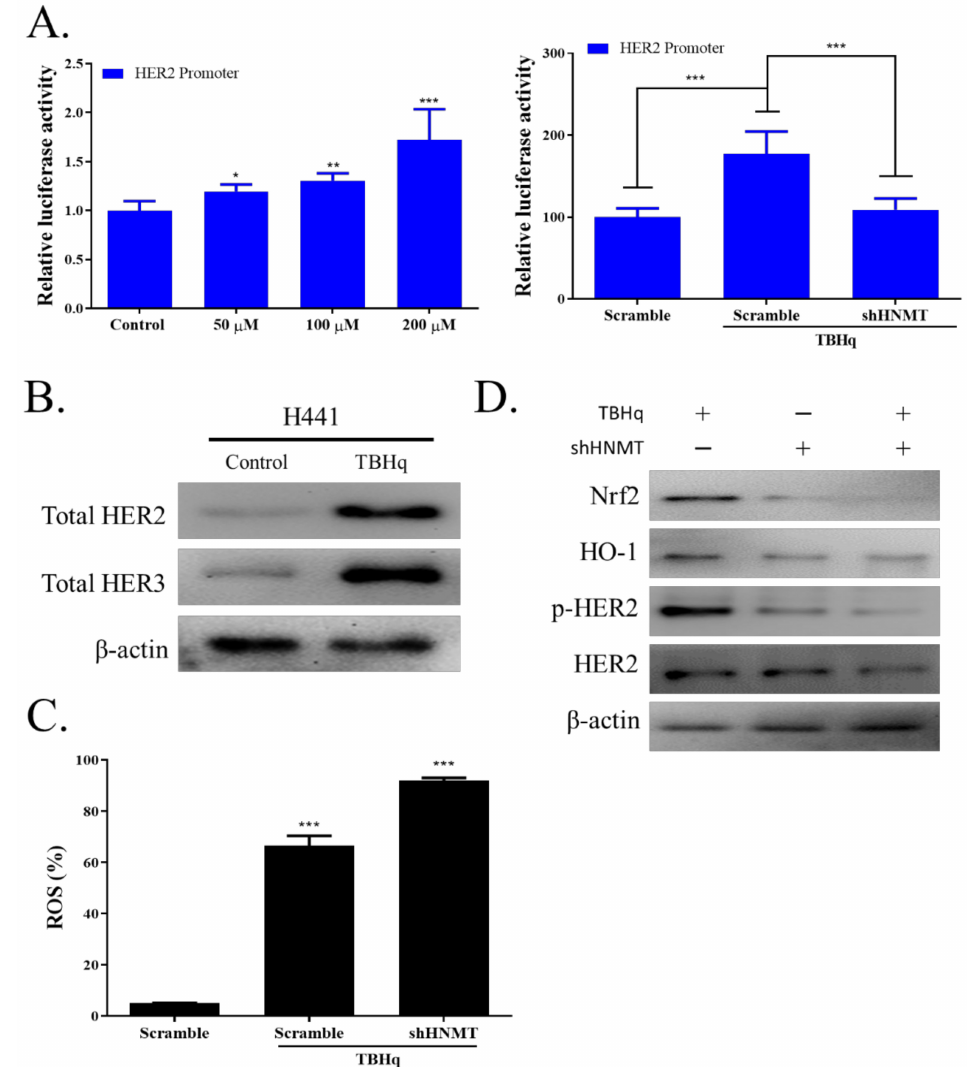
Figure 5. The negative influence of HNMT knockdown on HER2-dependent antioxidant response mechanism in lung cancer cells. ( A ) tBHQ-induced HER2 promoter transcriptional activity induction in a concentration-dependent manner. The H441 cell line was transfected and then treated for 4 h with various concentrations of tBHQ, as indicated. ( B ) Following tBHq treatment, immunoblot analysis showed total protein induction of both HER2 and HER3. Cells were treated with 200 µ M tBHQ for 4 h, lysed to extract the protein, and analyzed through Western blotting. ( C ) Flow cytometric analysis of tBHQ-induced ROS formation in H441 cells with or without shHNMT transfection using the ROS-sensitive fluorometric probe DCFDA. Relative ROS production in all the tested cells was normalized to the TBH1 + shHNMT group. ( D ) Immunoblot analysis of cells treated with 200 µ M tBHq with or without shHNMT transfection. NRF2, HO-1, pHER2, and HER2 were detected with their respective antibodies. * p < 0.05, ** p < 0.01, *** p <